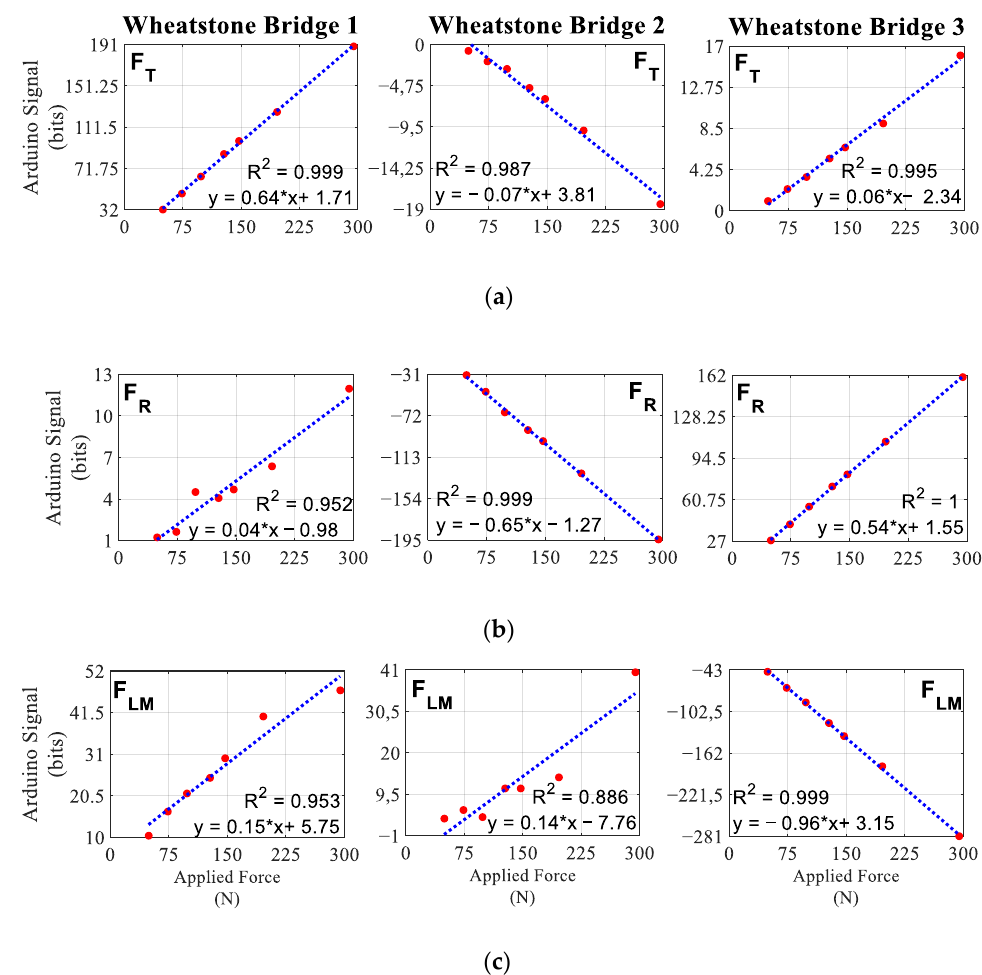
Figure 9. Regression lines of the signal of each Wheatstone bridge for different loads. ( a ) Results obtained when applying loads in the tangential direction. ( b ) Results obtained when applying loads in radial direction. ( c ) Results obtained when applying loads in lateral-medial direction.